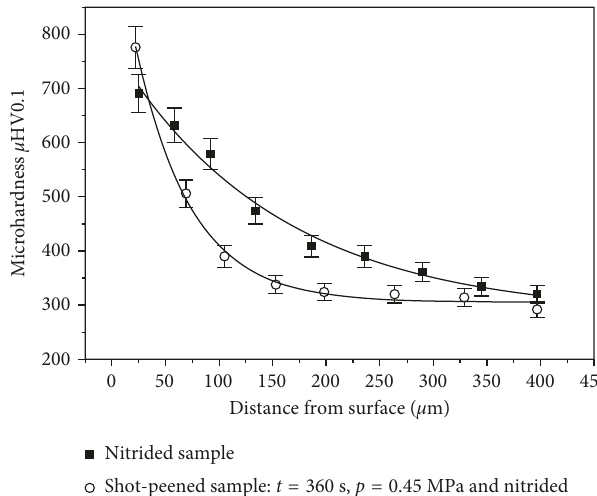
Figure 8: Microhardness ( µ HV0.1) profiles for the samples after nitriding and after combined shot peening and nitriding process.